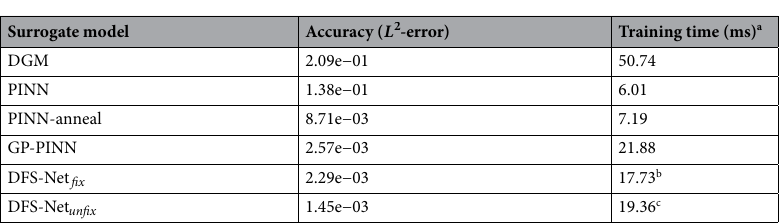
Table 3. Comparison of the relative L 2 -error of different neural network-based surrogate models on the Klein–Gordon equation. a The training time for each Adam epoch. b The training time of DFS-Net fix for each L-BFGS-B epoch is 41.14 ms. c The training time of DFS-Net unfix for each L-BFGS-B epoch is 44.44